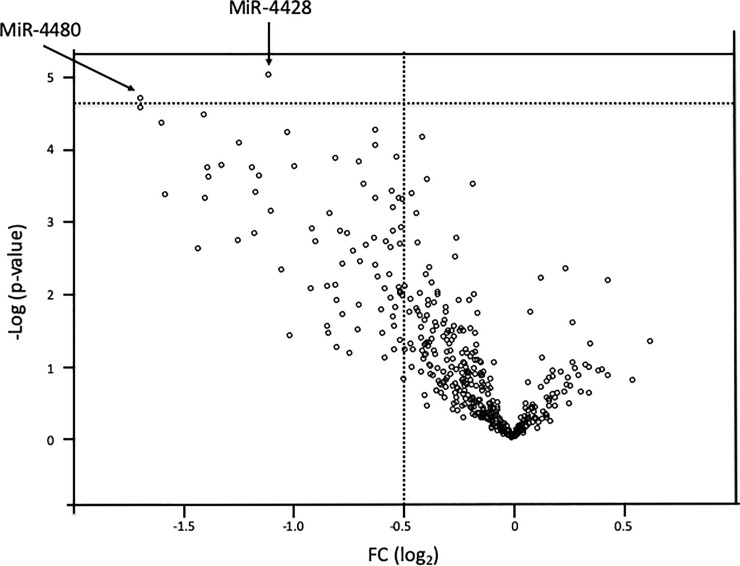
Volcano plots of microRNAs.FC, fold-change. Vertical dashed line shows the border of >0.5 |foled change| Horizontal dashed line shows the border of >0.01 p-value.